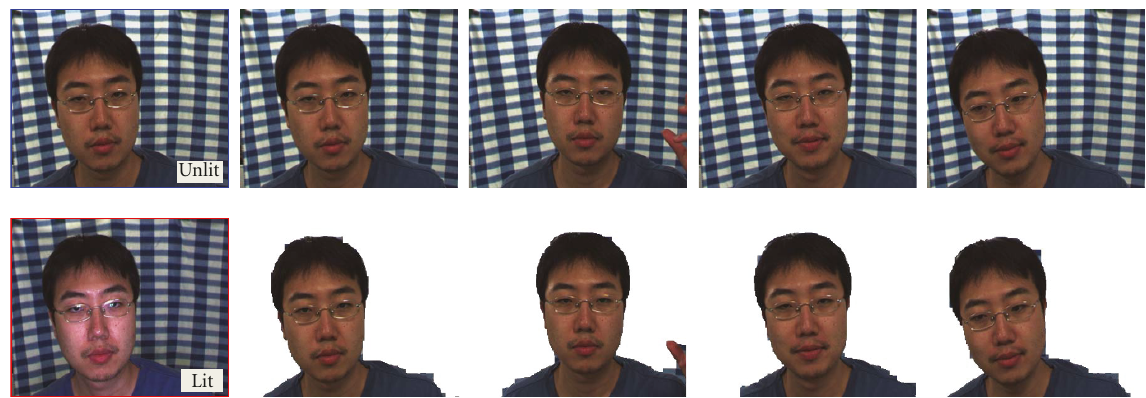
Figure 16: Segmentation of the “Man in Blue” sequence by the proposed algorithm II. The leftmost column shows a pair of unlit and lit frames, while the other columns show a series of unlit frames and their segmentation